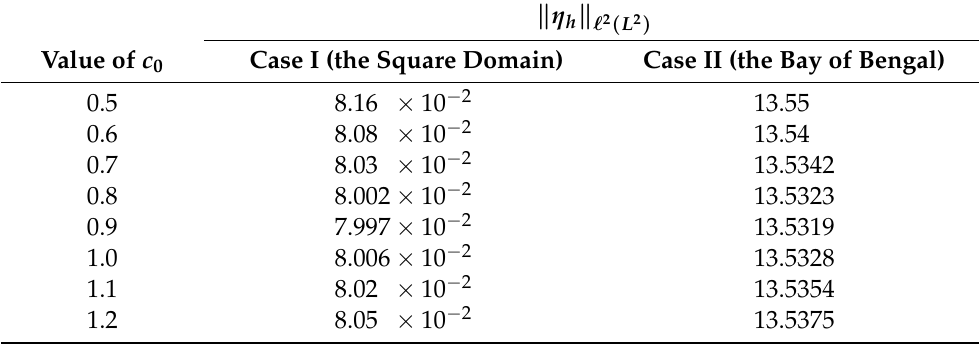
Table A1. Values of c 0 and (cid:107) η h (cid:107) (cid:96) 2 ( L 2 )